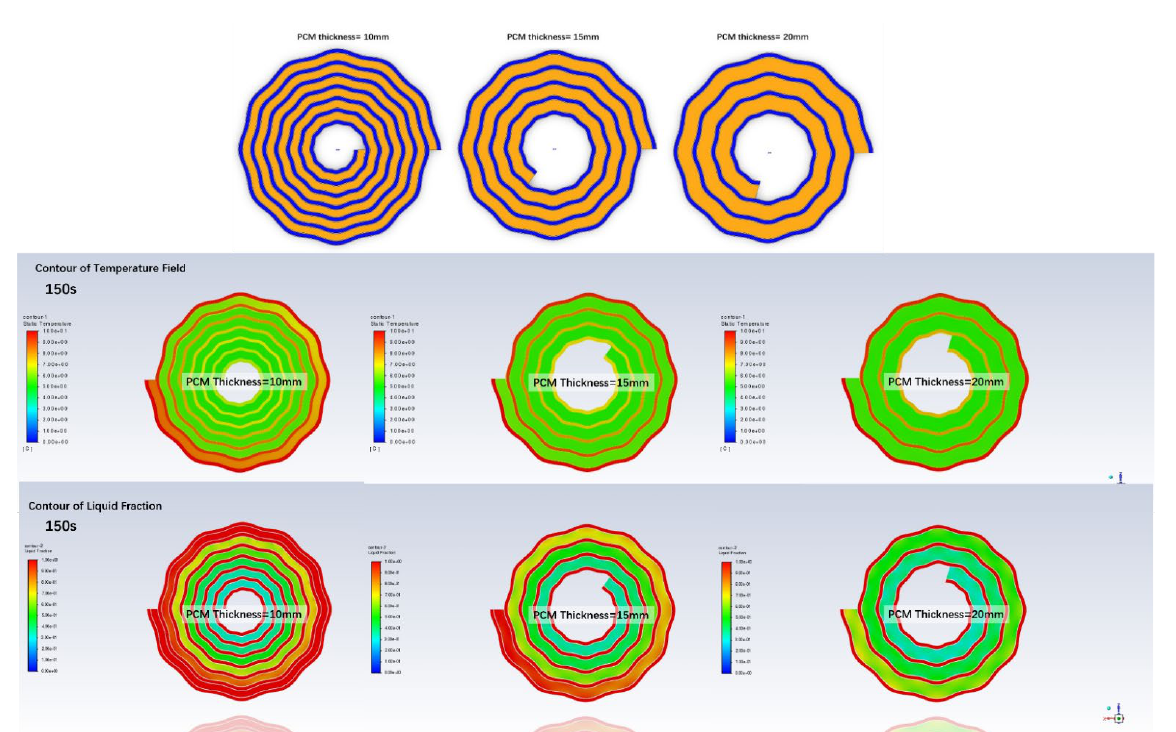
Figure 14. Cold storage tanks structure with various PCM thickness per layer, and contours of tem- perature field and liquid fraction at 150 s during a discharge.